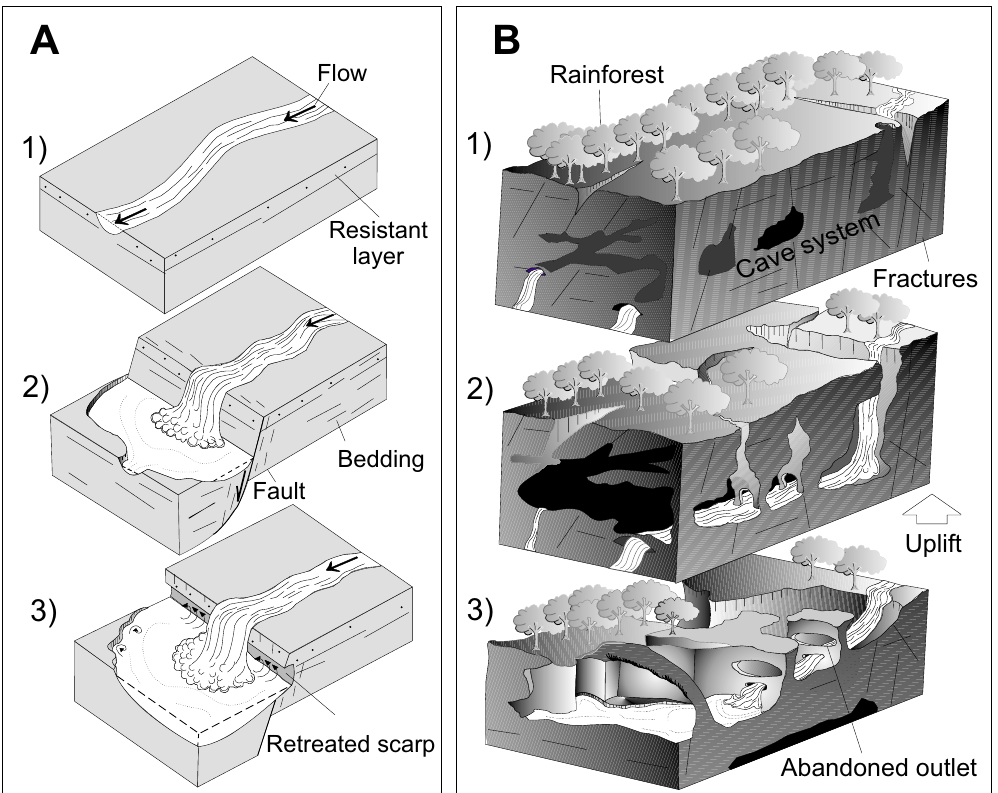
Fig. 8 – Block diagrams summarizing the evolution of the Presidente Figueiredo waterfalls. A) Waterfalls developed from normal faults: 1)Area before tectonism; 2) intersecting of rivers for normal faults, originating waterfalls; and 3) hollowing out and consequent collapse of the wall composed of weakened rocks, promoting escarpment retreat. B) Waterfalls controlled by pseudokarstic relief, exemplified byArcos Waterfall: 1) Caves and pipes formed by dissolution and hydrodynamic removal in the phreatic zone; 2) uplift of the area and intensification of processes of cave formation and beginning of relief dissection 3) present configuration of the waterfall area, with ruiniform relief sculptured upon ancient pseudokarstic